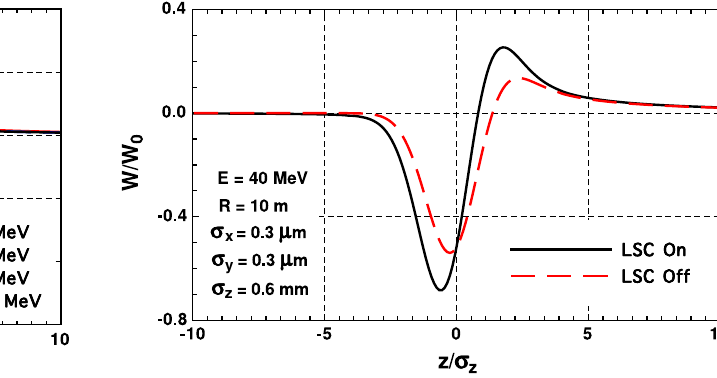
FIG. 21. (Color) The steady-state kick due to CSR alone and the combined CSR and SC kick for a 40 MeV beam.